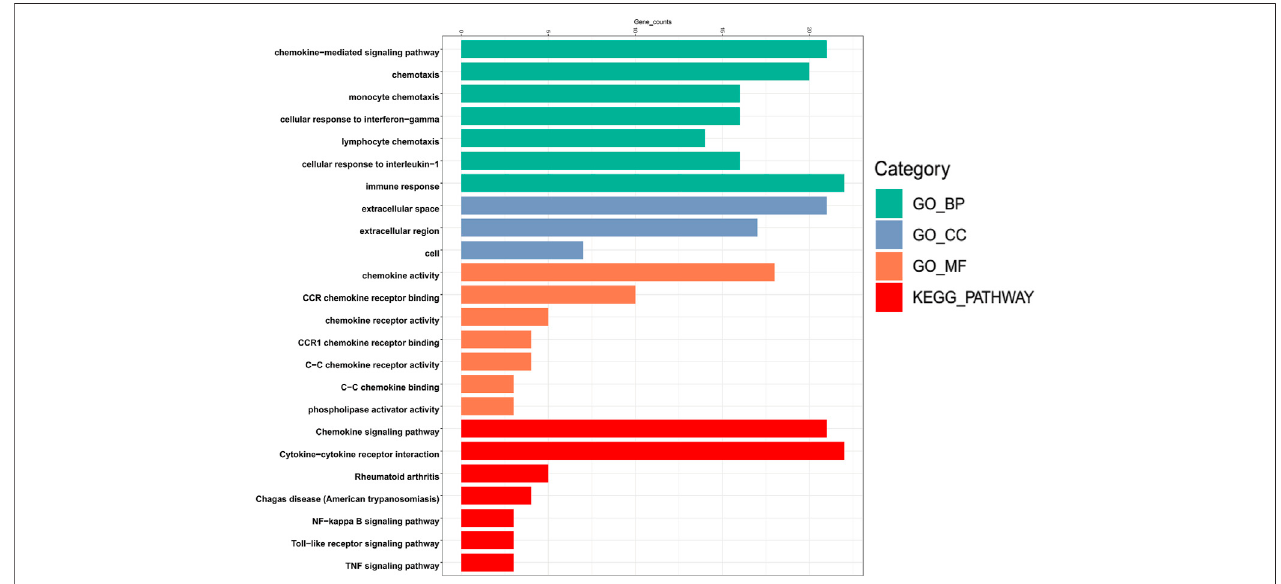
FIGURE 7 | Bar plot of GO enrichment in cellular component terms, biological process terms, molecular function terms, and KEGG enriched terms of aberrantly expressed chemokines CCL and their most frequently altered neighboring genes in LIHC (David 6.8).